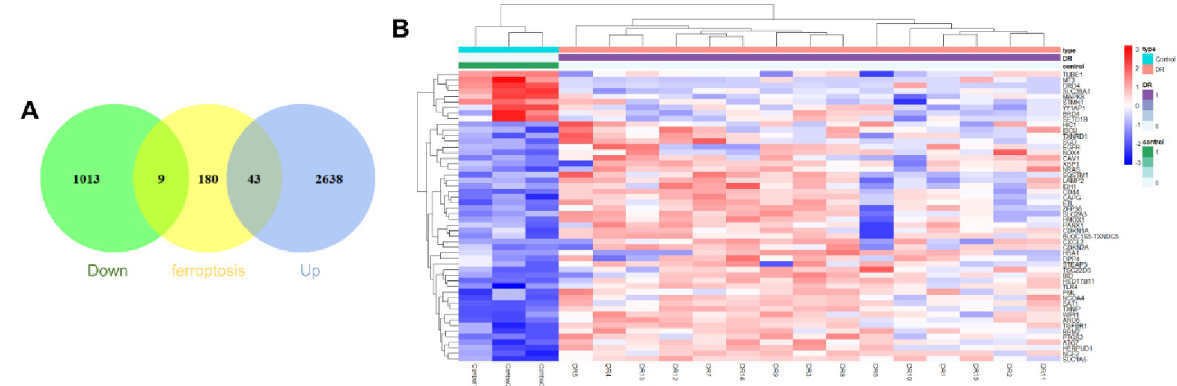
Fig 3. Acquisition of DE-FRGs and their differential expression in the DR and control groups. (A) 3703 DEGs were intersected with the ferroptosis dataset to obtain 52 DE-FRGs. Down (green) represents the number of genes in the negative correlation module, ferroptosis (yellow) represents the number of ferroptosis genes, and Up (cobalt blue) represents the number of genes in the positive correlation module. (B) The heat map showed the distribution of 52 DE-FRGs in the DR and control groups. Blue represents down-regulated genes; red represents up-regulated genes.